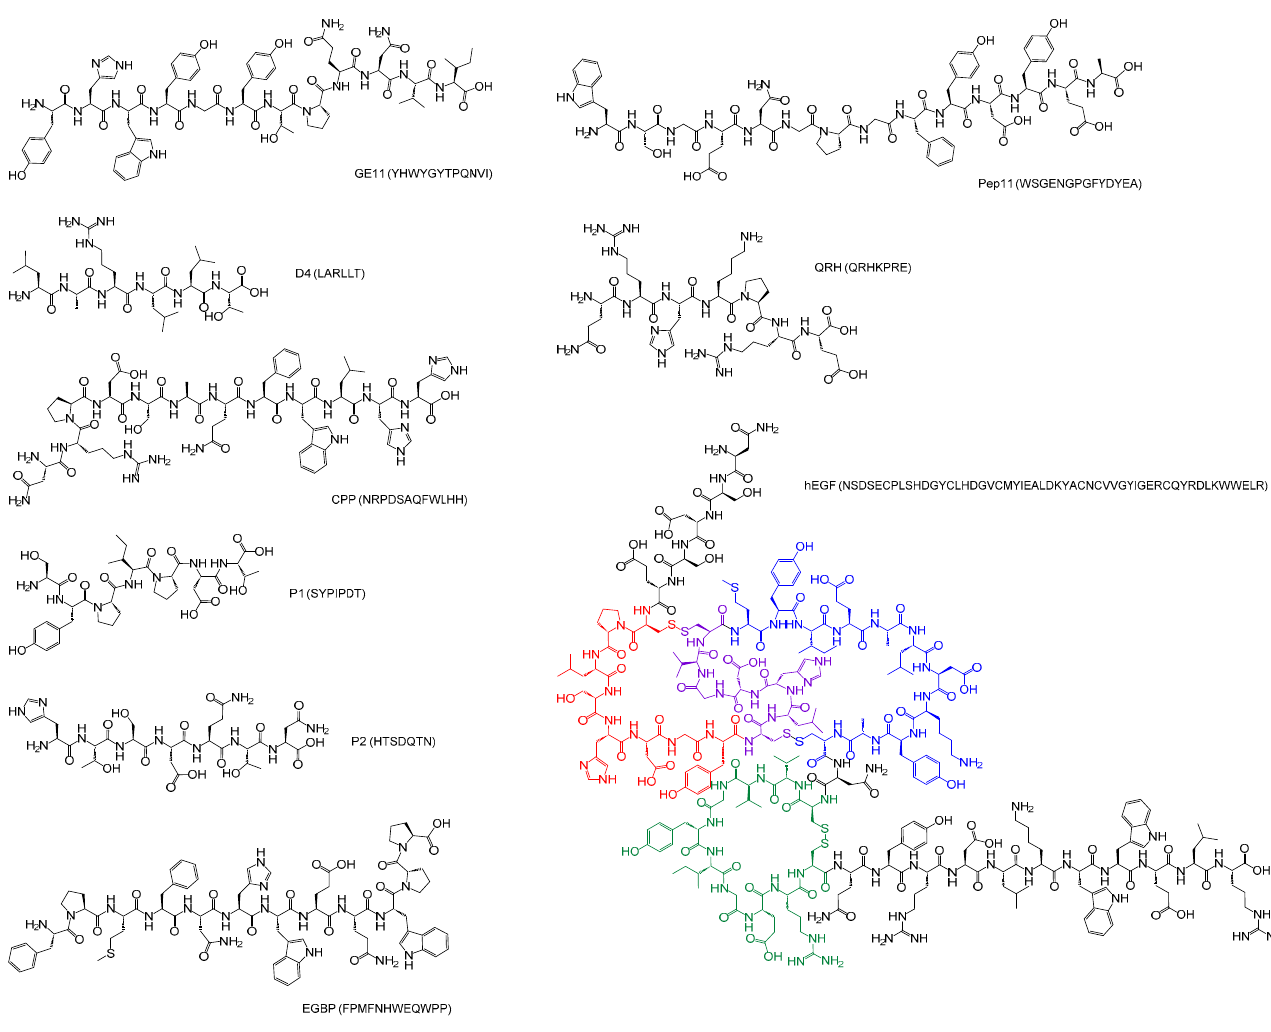
Figure 1. Structures of the peptide leads GE11, D4, CPP, P1, P2, EGBP, Pep11, QRH and hEGF of which chelator-modified and radiolabeled analogs were developed of and tested for their potential to be applied as agents for EGFR-specific tumor targeting. In the structure of hEGF, the three loops of the peptide are colored in red (A loop), blue (B loop) and green (C loop), while the part of the peptide belonging to both the A and the B loop is depicted in purple.